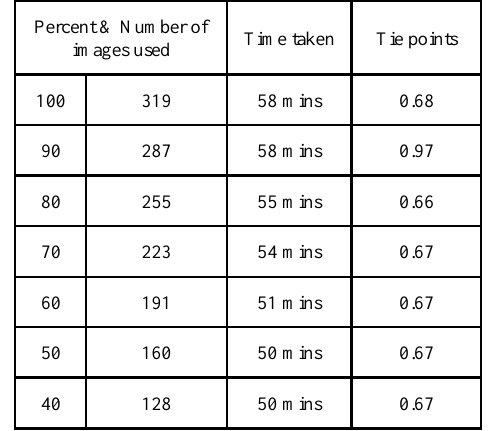
Table 4 . Time taken to generate mosaics with different percent of aerial images acquired at a flight height of 15 m. All 319 Figure 6 . Mosaic generated with 100%, 80%, 60%, 40% of aerial images were used for aligning and mesh building, prior to aerial images acquired at a flight height of 15m. generating the mosaic. Mosaic generated with 100% of images (n = 319) acquired at